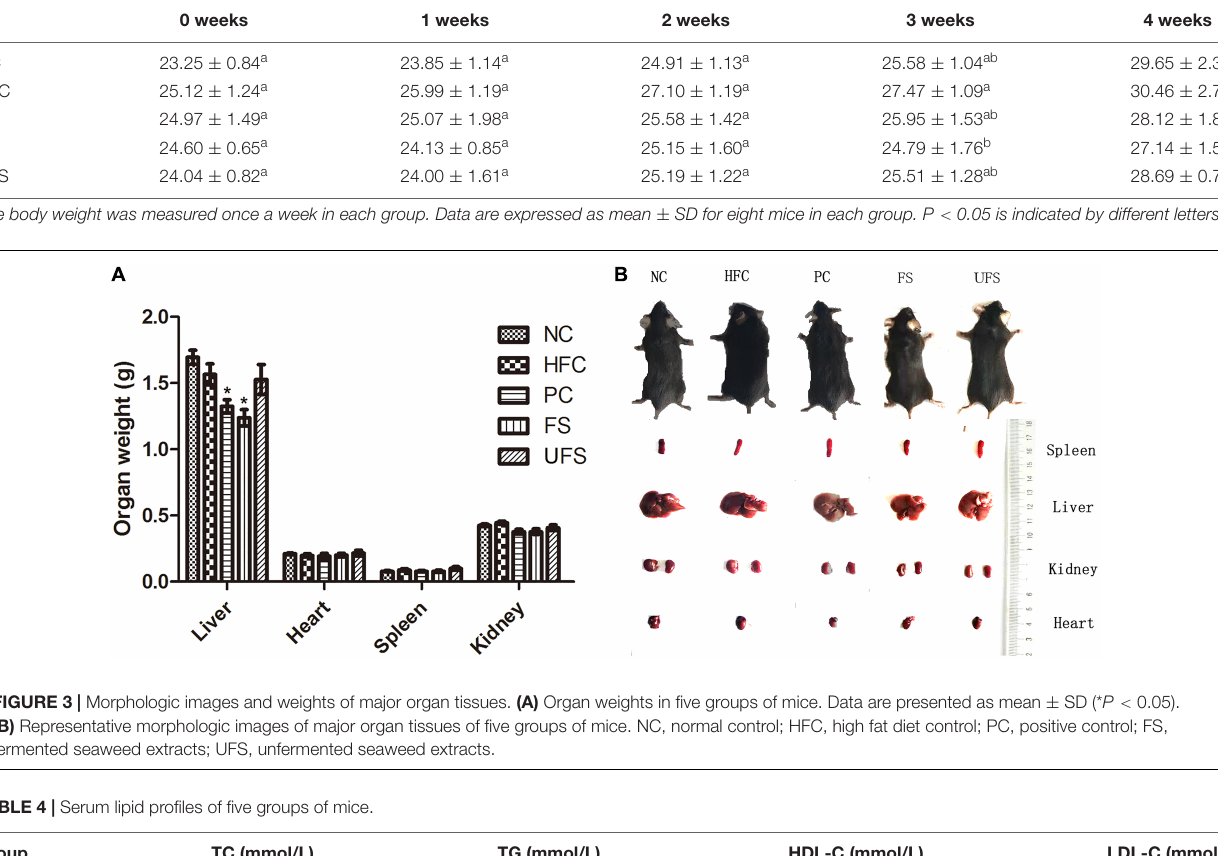
TABLE 3 | Body weight evolution during the experimental period of five groups of mice. Group Body weight (g)